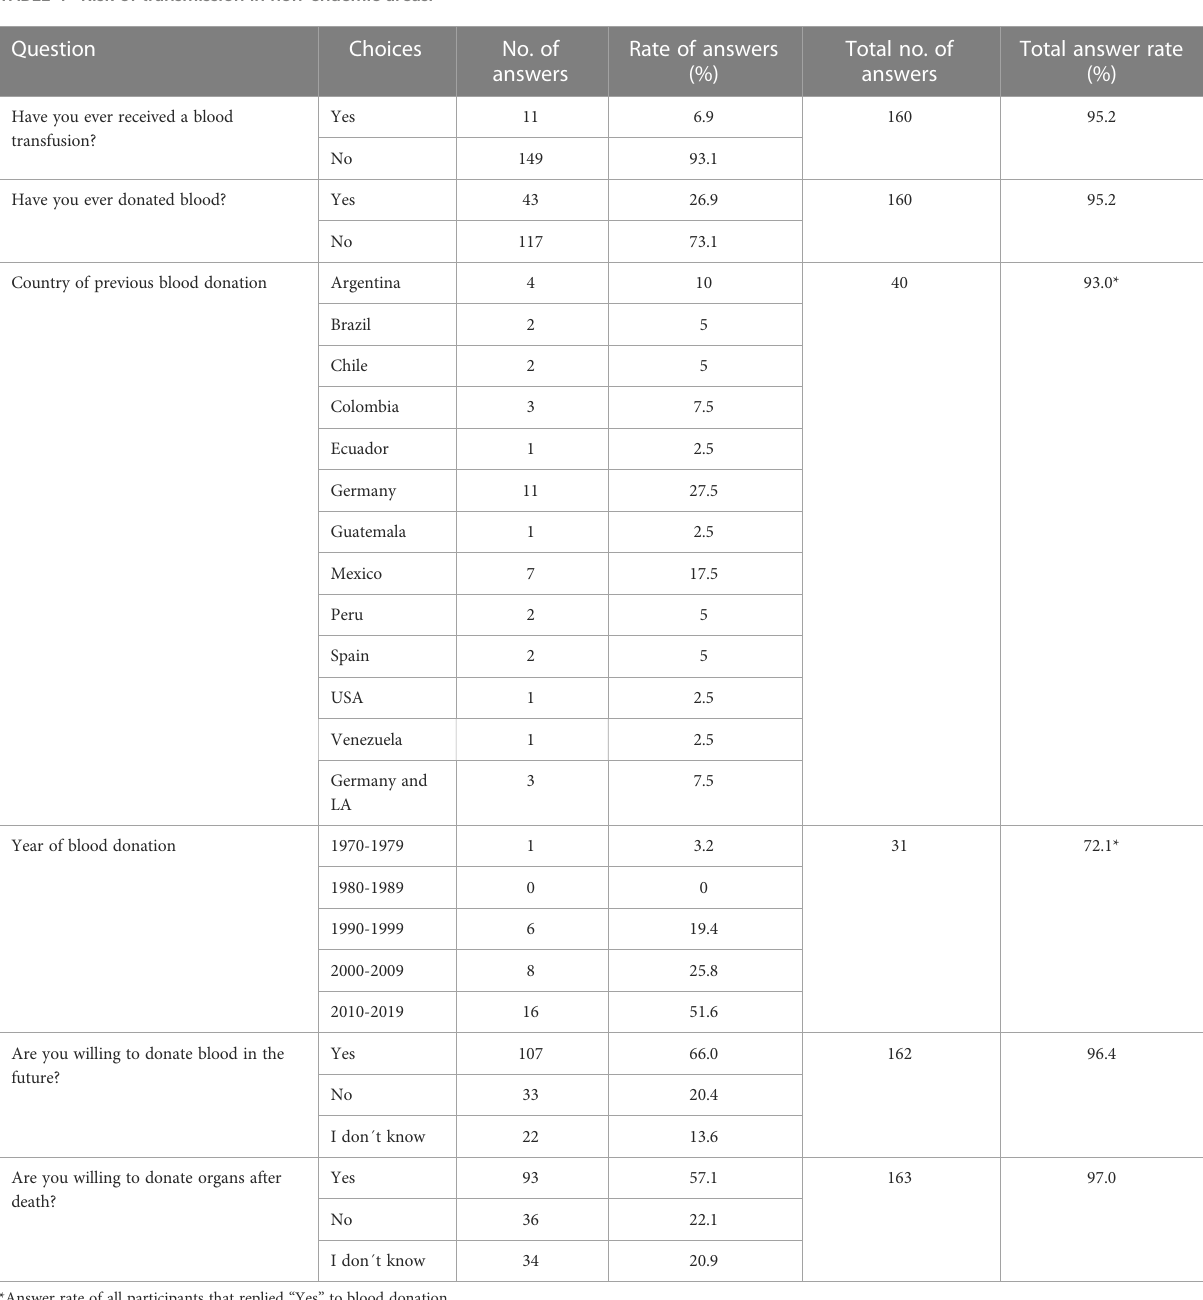
TABLE 4 Risk of transmission in non-endemic